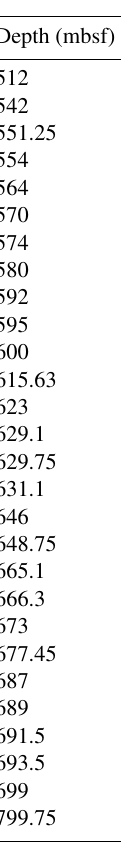
Table 2. Palaeomagnetic and biostratigraphic tie points used in the primary age model of Site U1389 based on shipboard data follow- ing Hernández-Molina et al. (2013) and Stow et al. (2013). 1: Grad- stein et al. (2012); 2: Raffi et al. (2006); 3: Lourens et al. (2004); 4: Grunert et al.